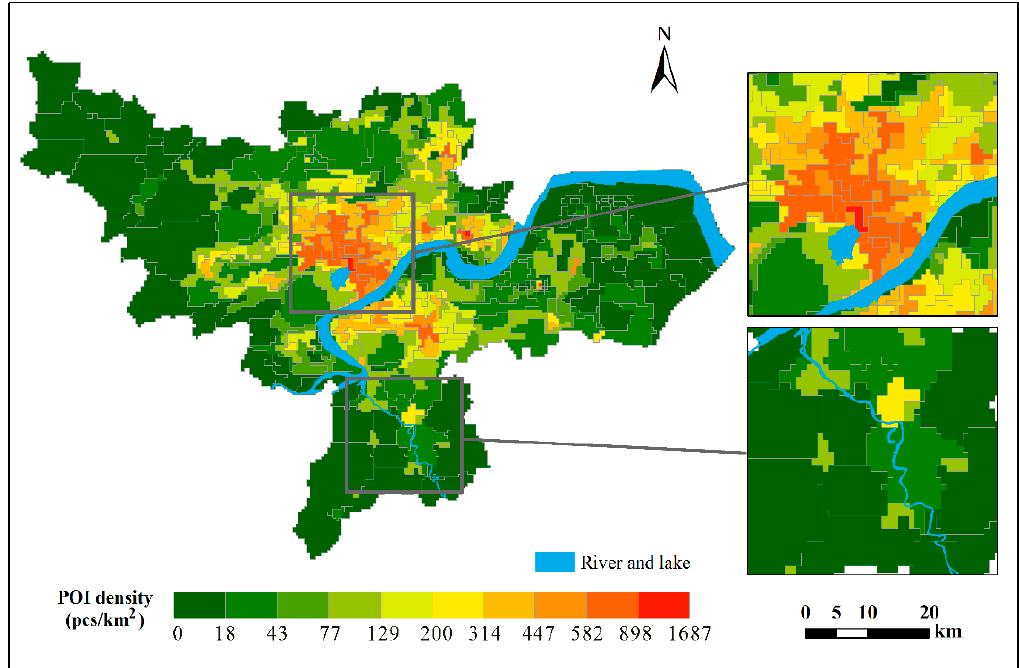
Figure 8. Density of POI counted in segmentation units. The small images on the right show detailed views of the areas of small units and big units respectively.